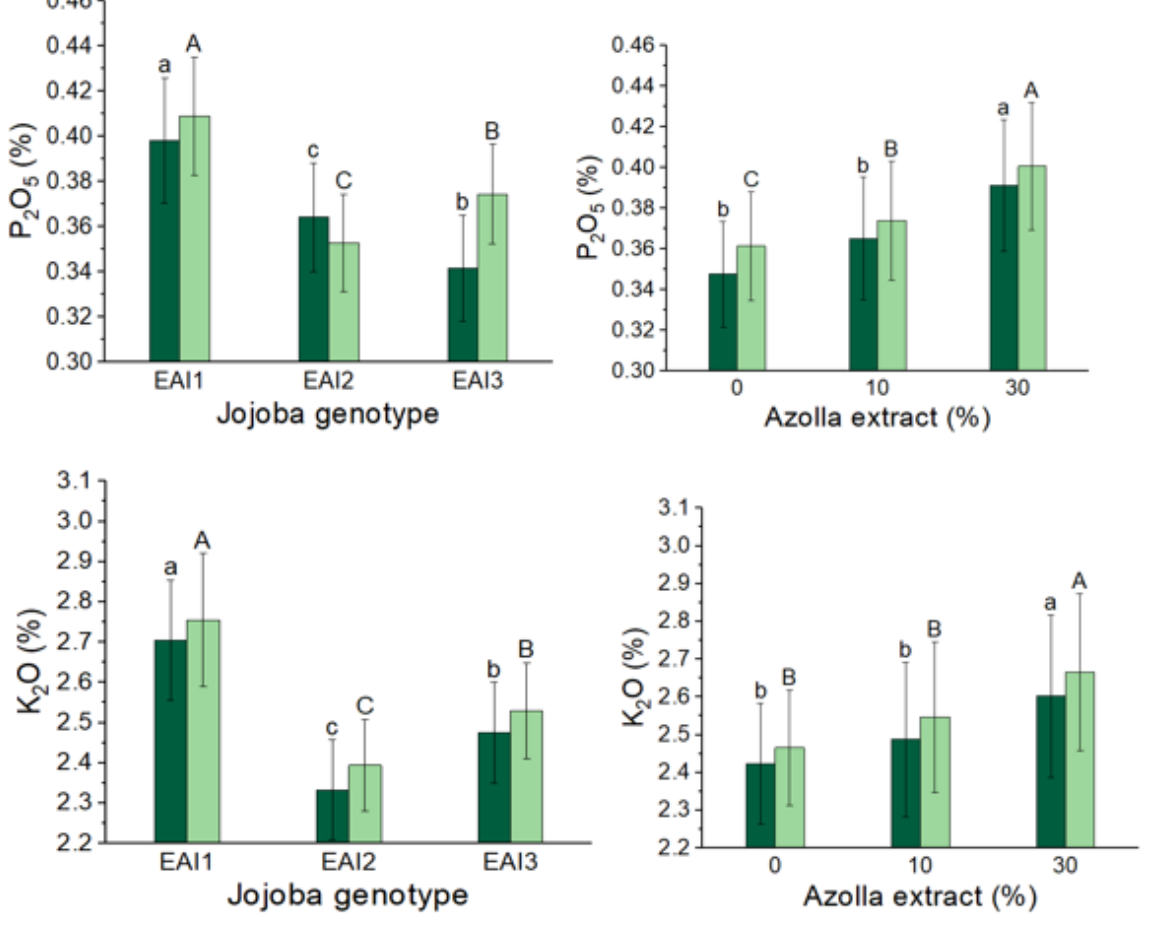
Figure 7. In both seasons, the mean values of nitrogen (%), phosphorus (%), and potassium percentage (%) of jojoba shrubs were modified by plant genotypes and foliar application of Azolla filiculoides Lam. plant extract respectively. The data are expressed as a mean value ± SE. at the 0.05 level, bars with identical letters are not significant. Table 8. In both seasons of the study, the mean values of nitrogen (%), phosphorus (%), and potassium percentage (%) of jojoba shrubs as influenced by combined treatments of plant genotypes and foliar application of Azolla filiculoides Lam. plant